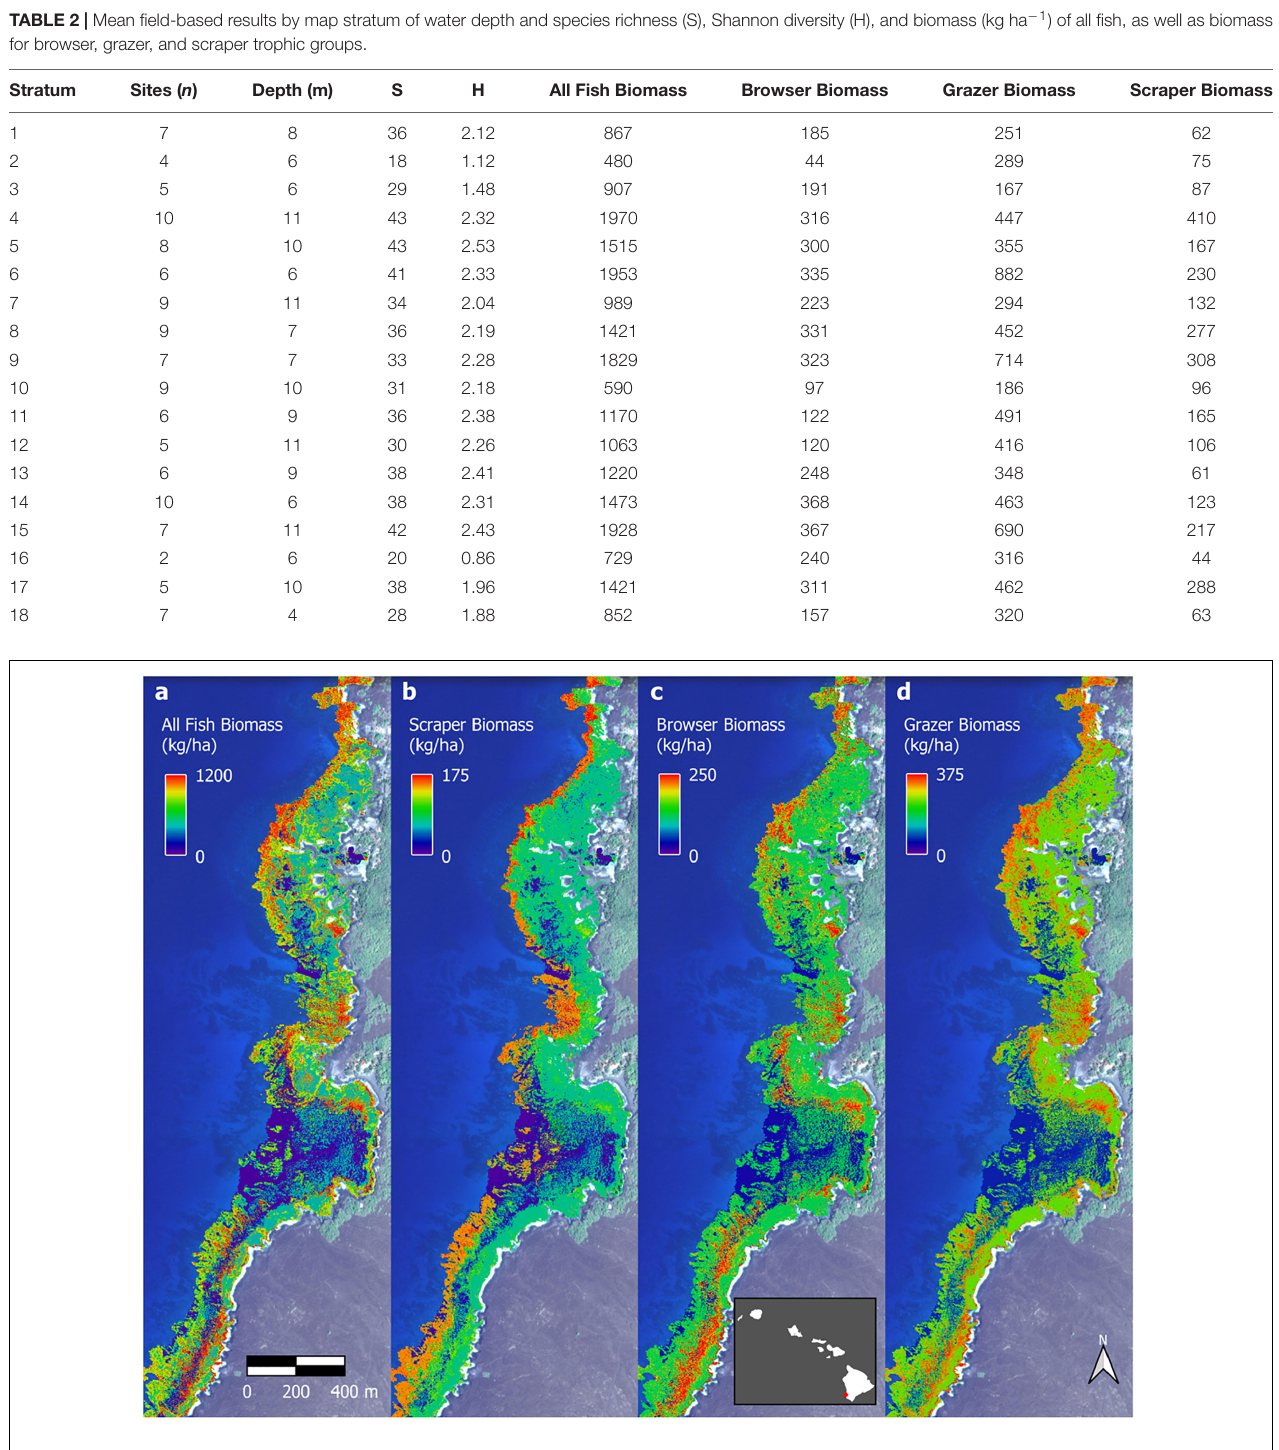
FIGURE 7 | Example fish biomass maps of Honomalino Bay for (a) all fish, and for fish classified as: (b) scrapers, (c) browsers, and (d) grazers. Distributional pattern differences can be seen between the different trophic groups, especially across depth gradients. Full maps in Supplementary Figures 7–10 . Background imagery retrieved from Google, ©2021 Maxar